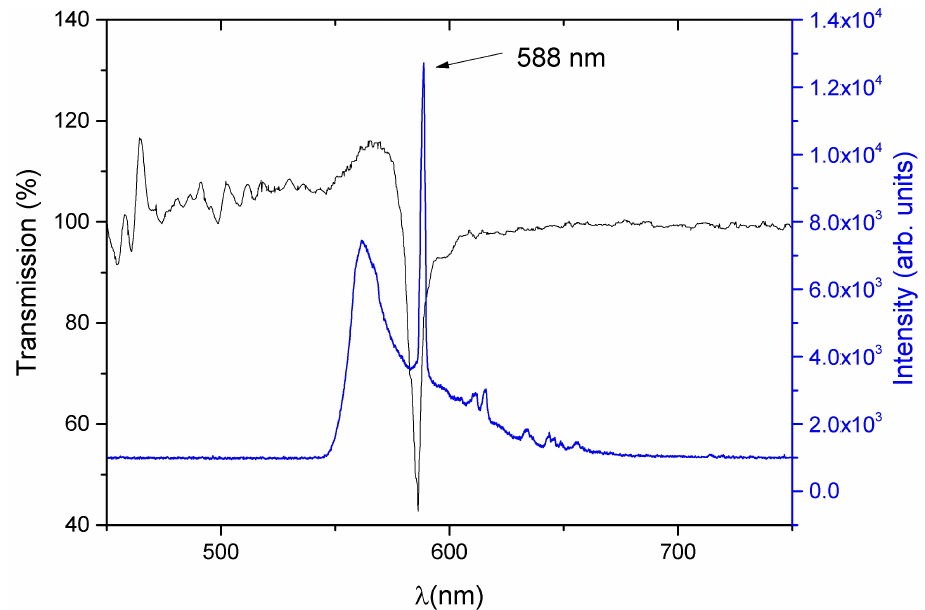
Figure 5. Typical lasing effect (in blue) observed by pumping the grating structure with a fluence of ≈ 40 mJ/cm 2 , λ = 532 nm and τ = 4 ns. In black the reflection peak recorded in the active mixture.